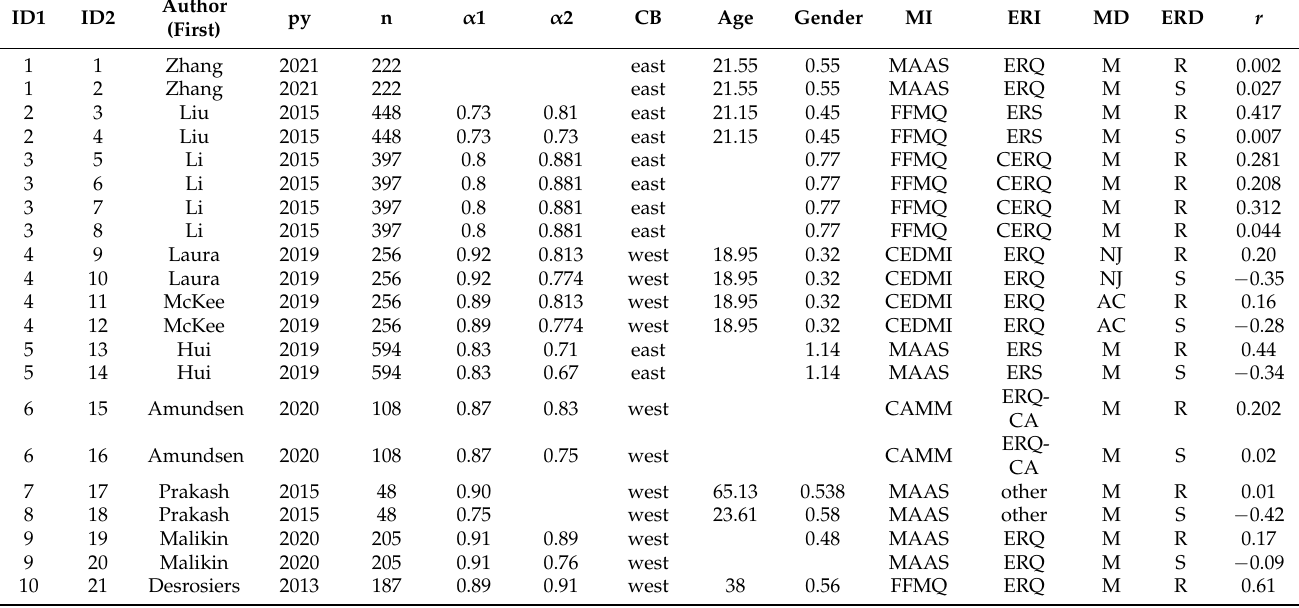
Table A1. Coding table of the three-level meta-analysis of the relationship between mindfulness and cognitive reappraisal and expressive